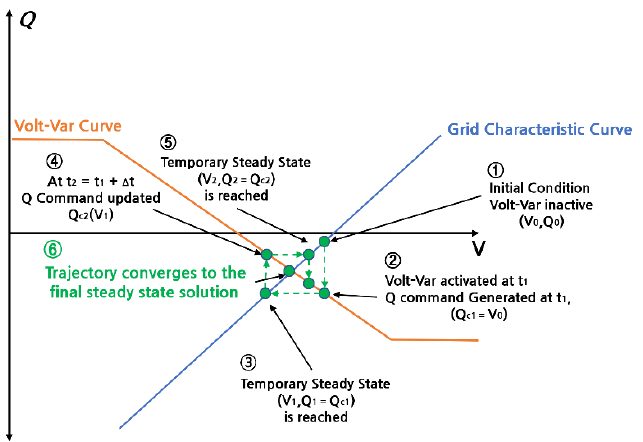
Figure 2. Stable VVC operation.